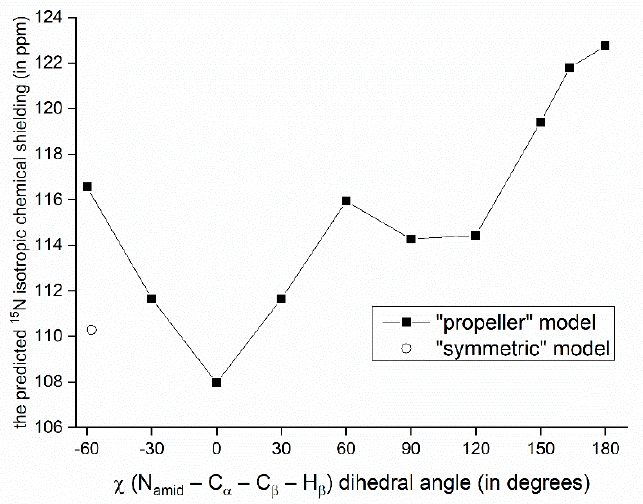
Figure 4. Variation of the GIAO-B3LYP/6-311++G(2d,2p) 15 N chemical shielding with the sidechain dihedral angle. The point marked by an open circle has of a value of χ found in the PW PBE geometry of the “symmetric” polymorph.